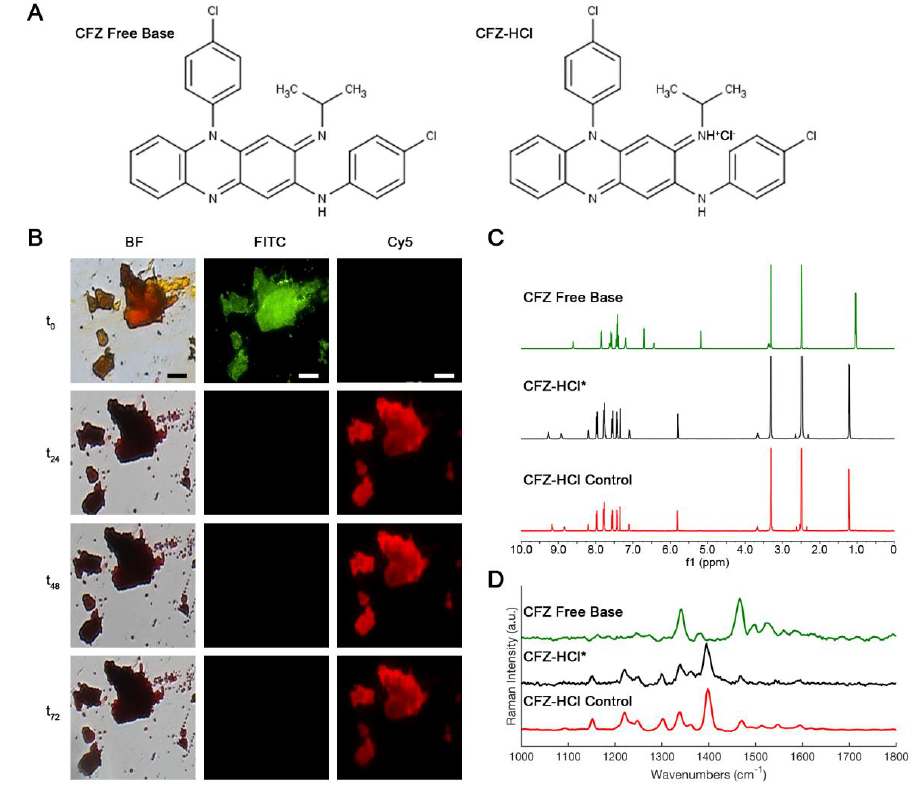
Figure 2. Chemical structures of CFZ free base and CFZ-HCl ( A ). Brightfield (BF)/fluorescent (FITC, Cy5) microscopy images ( B ); 1 H-NMR ( C ), and Raman micro-spectroscopy spectra ( D ) of synthesized CFZ-HCl salt crystals via new synthesis scheme (*) compared to the established CFZ-HCl salt crystals and CFZ free base. Scale bar = 50 µm.